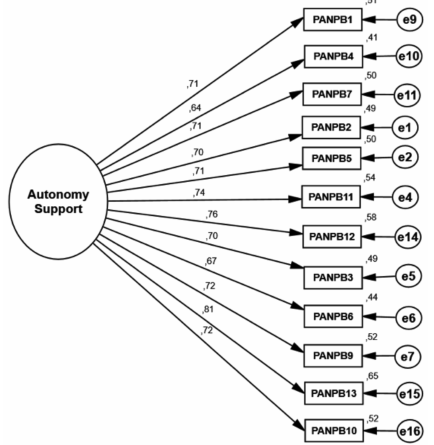
Figure 4. Standardized individual parameters (covariance factors, factorial weights and measurement errors), all of which were significant in the measurement model (PESSp - one factor/12 items) for the Portuguese validation